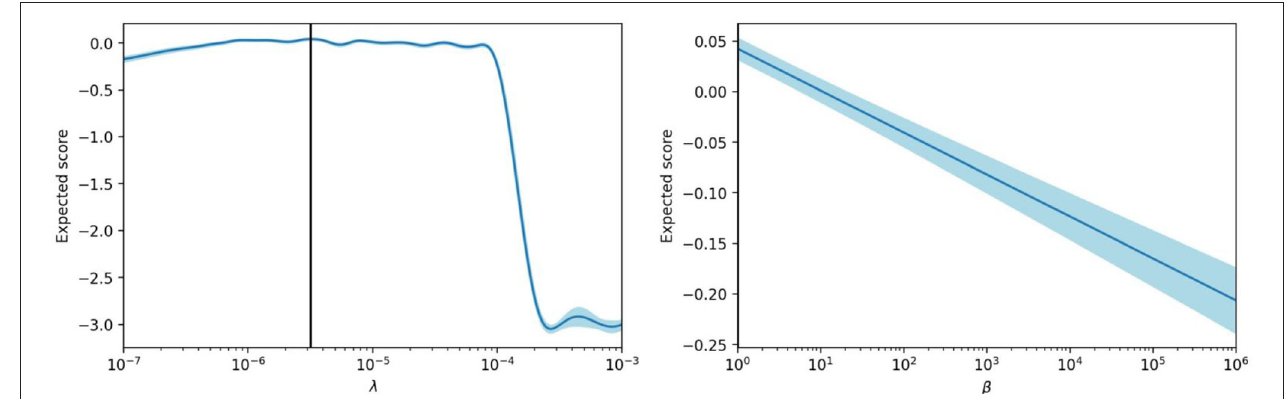
FIGURE 5 | Score estimation of the hyperparameter optimizer with regard to the learning rate λ and the coefficient β , for the EWC